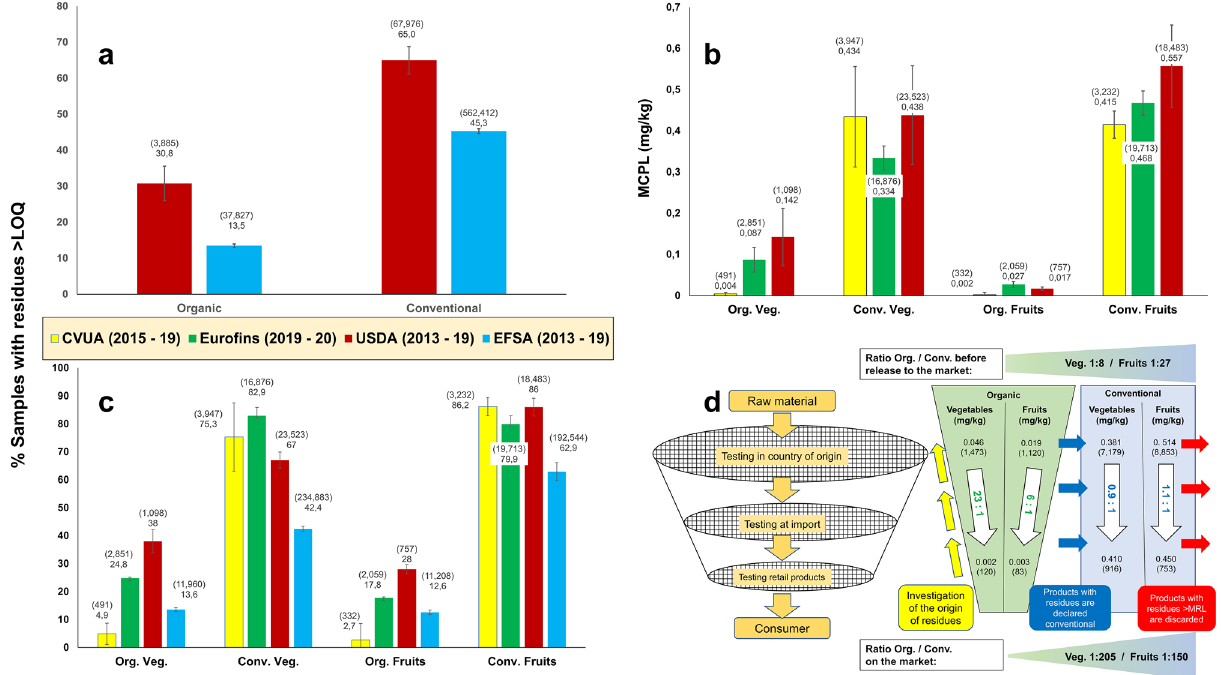
Figure 1. Pesticide residues in conventional and organic food in tests conducted by four organisations: EFSA (European Food Safety Authority) collects official data from all EU member states 3 , CVUA from one federal state in Germany 4 , USDA from government laboratories across the U.S. 5 , while Eurofins is a commercial laboratory in Germany. Figures in brackets represent the number of samples. The legend is valid for ( a ), ( b ) and ( c ). In order to increase the number of samples (represented in brackets) and thus their representativeness, figures from several years were grouped together, as available from each organisation. Black bars symbolise standard errors across years. ( a ) Shows the percentage of samples with residues above the limit of quantification (LOQ), for all types of food ( available from two organisations only). ( b ) Represents the mean cumulative pesticide load (MCPL) for fruits and vegetables (available from three organisations). ( c ) Similar to ( a ), but for fresh fruits and vegetables only (CVUA uses "above 0.01 mg/kg" instead of LOQ, but this is identical for most substances). The same datasets were used for ( b ) and ( c ). ( d ) Multi-layer sieving model for residue testing of fruits and vegetables in 2019, at different points of the organic supply chain. The data above the white arrows are from the commercial laboratory Eurofins, and mostly represent the situation before products are released to the market, while the figures below the white arrows are from CVUA, representing the situation on the market (both wholesale and retail). Ratios from "before market" to "on market" are shown in the white arrows. In this process, the MCPL remains in the same range for conventional products (blue rectangle to the right), while it is reduced massively for organic products (green trapezium in the centre). As a result of this sieving mechanism, residues in samples from the market are 150 and more times lower in organic than in conventional produce (trapezium at the bottom). This shows that the process represented by the blue arrows works fairly well—which is not always the case for the investigation of the origin of such residues, symbolised by the yellow